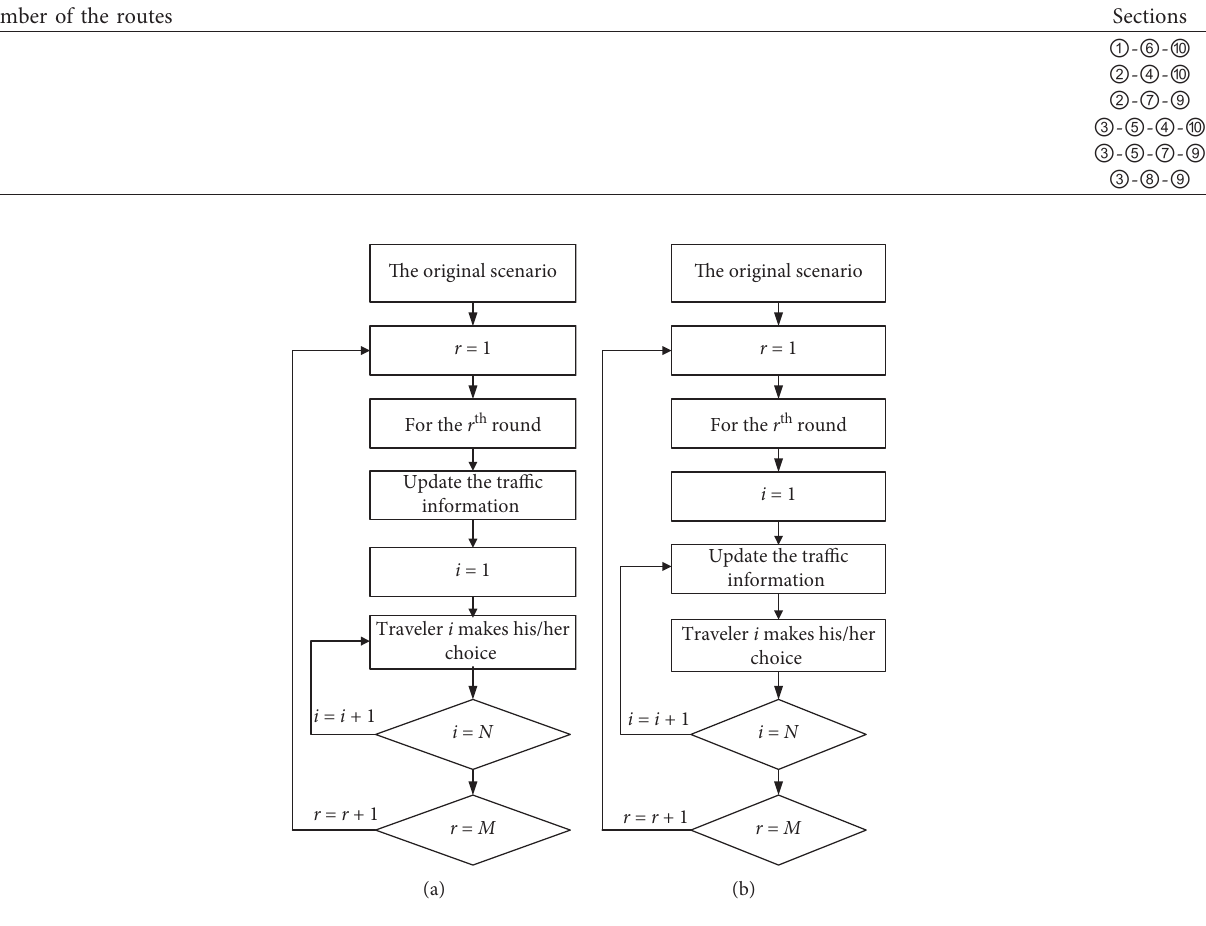
Figure 2: Experiment process. (a) Scenario 1 and Scenario 2 (historical information). (b) Scenario 3 and Scenario 4 (real-time information).